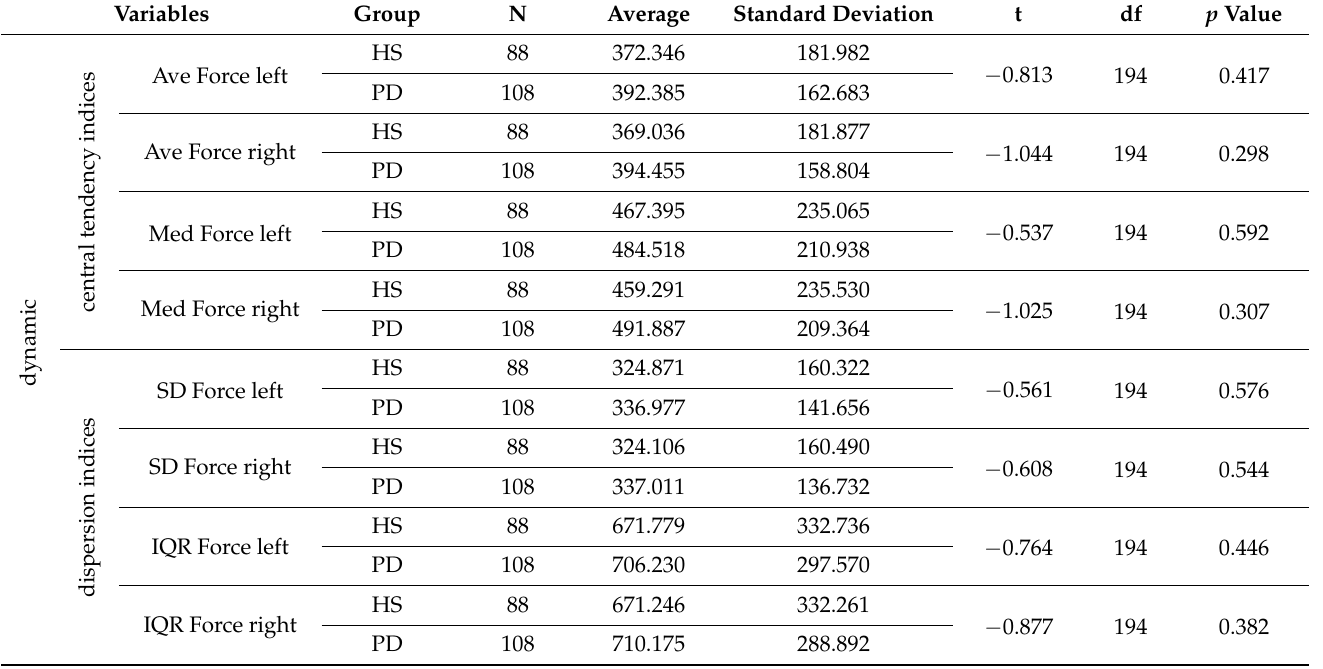
Table 5. Dynamic central tendency and dispersion indices.